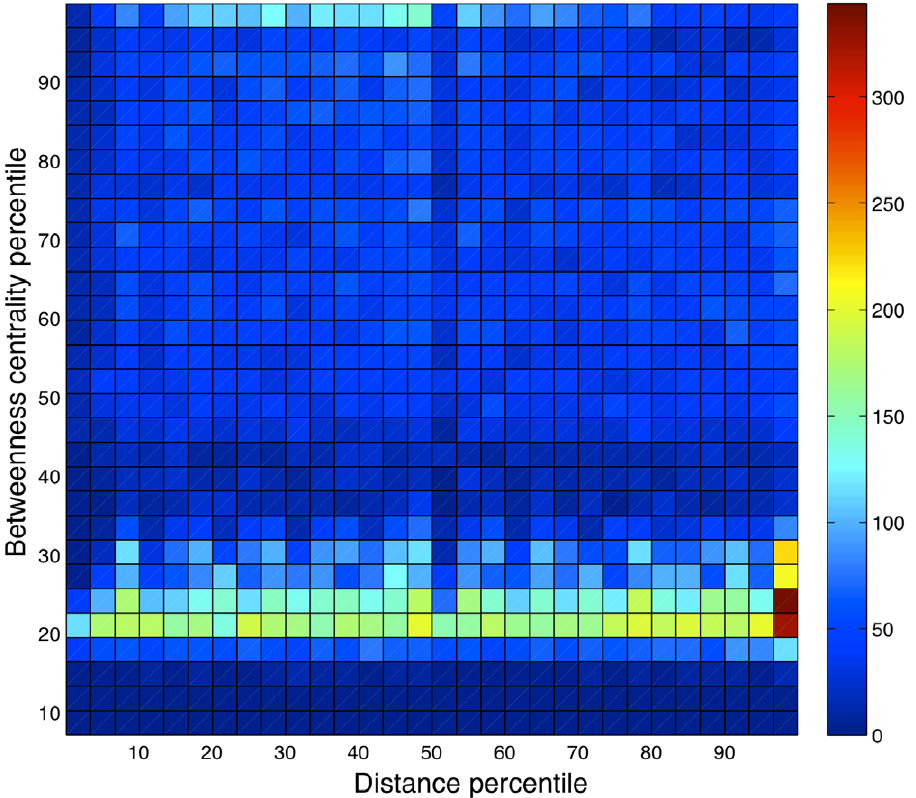
Figure 3. Relationship between topological centrality and geographic centrality. 42,123 nodes in communities varying in size from 10 to 1,000 are examined, and both quantities are measured in terms of percentiles. The number of observations (nodes) that lie within each bin is indicated by its color.